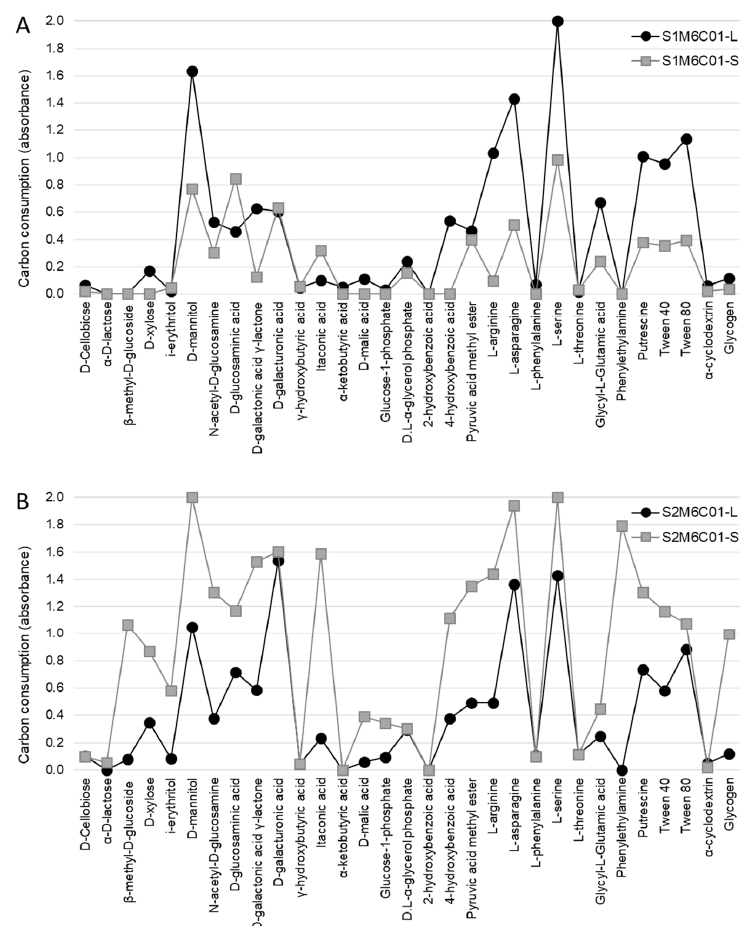
Figure 4. Metabolic profiles of M6C01. Consumption of the 31 carbon-sources by the lichen (-L) and substrate (-S) microbiotas associated with the symbiotic pair composed of the mycobiont haplotype M6 and the cyanobiont C01 haplotype from both sampling sites: S1 ( A ) and S2 ( B ).